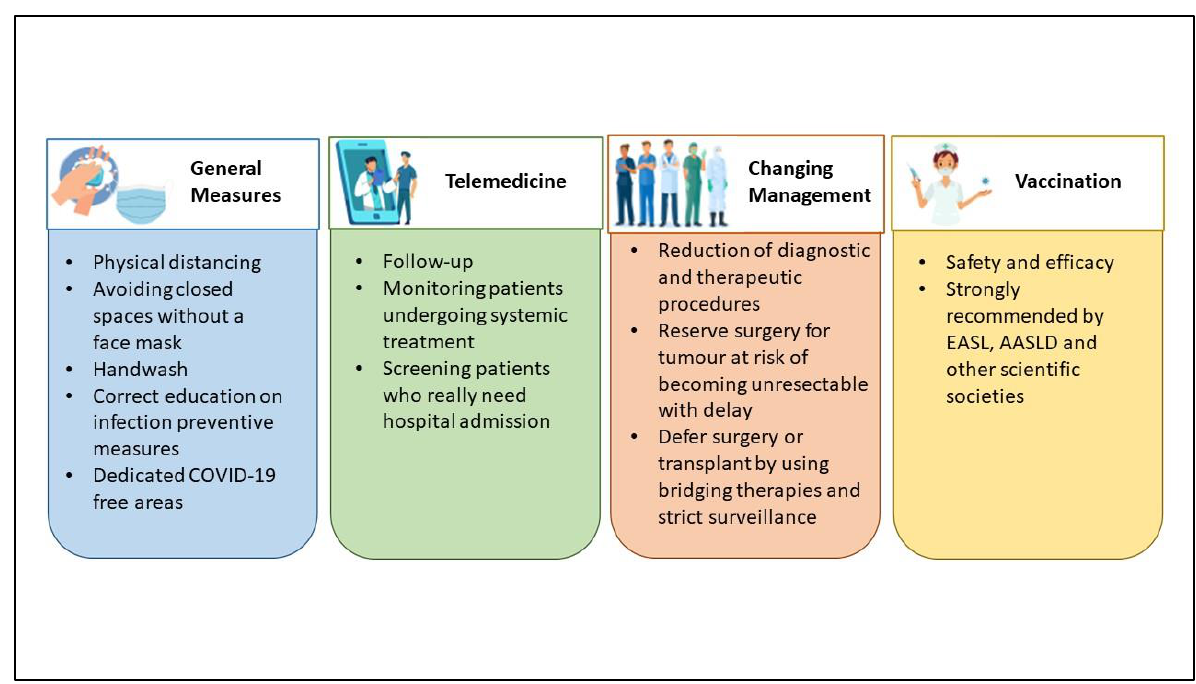
Figure 1. Measures to minimize the risk of COVID-19 in HCC (hepatocellular carcinoma) patients. General measures for all patients, such as physical distancing, staying away from closed spaces without a face mask, handwashing, and correct education on infection pre- ventive measures, may be enough for preventing the infection in CLD and HCC patients [2,17]. Measures required largely differ across regions and individual institutions, accord- ing to the level of effort imposed by the pandemic (for example, the availability of re- sources such as personal protective equipment and inpatient beds as well as the number of inpatients infected with SARS-CoV-2)